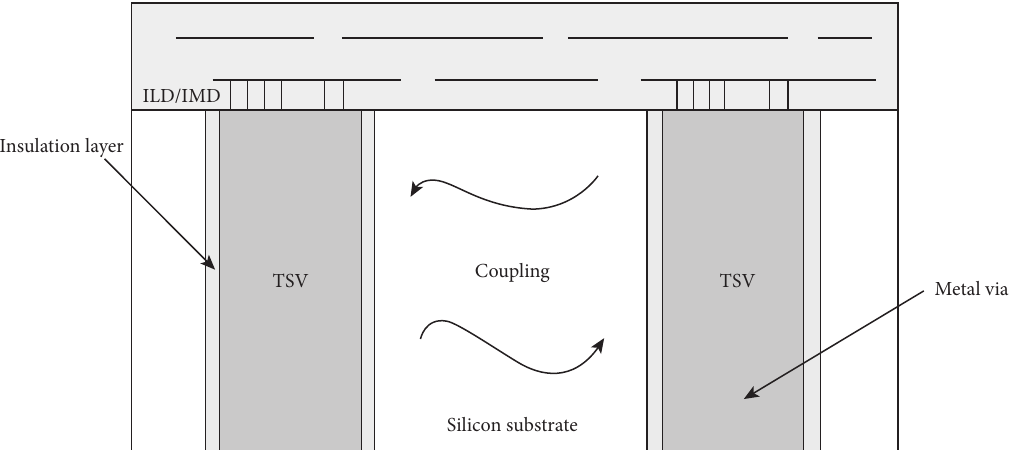
Figure 2: A conceptual view of TSV-TSV noise coupling.